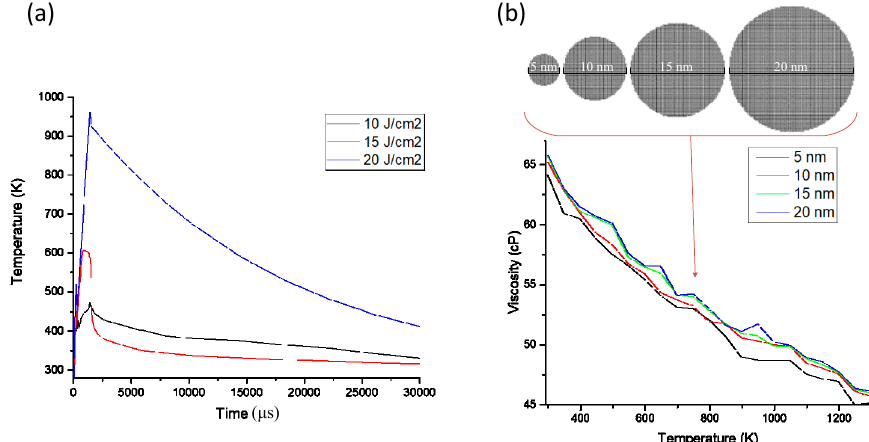
Figure 5. ( a ) Temperature vs. time under different flash sintering power densities; ( b ) viscosity of nano-silver particles of different diameters and temperatures.